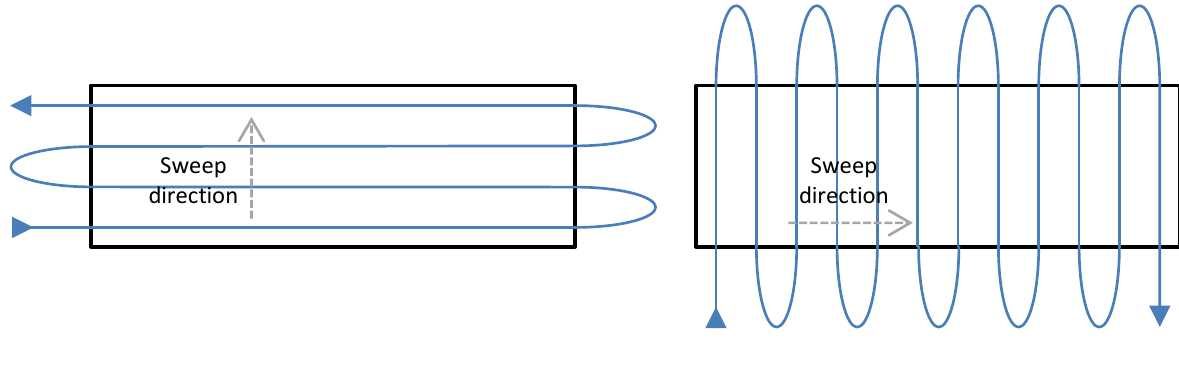
Figure 1. Coverage strategy used in this work. A rectangular area is covered using a back and forth motion along lines perpendicular to the sweep direction. Notice that the sweep direction highly influences the number of turns outside the area to be covered, thus affecting the coverage time. The optimal sweep direction is parallel to the smallest linear dimension of the area